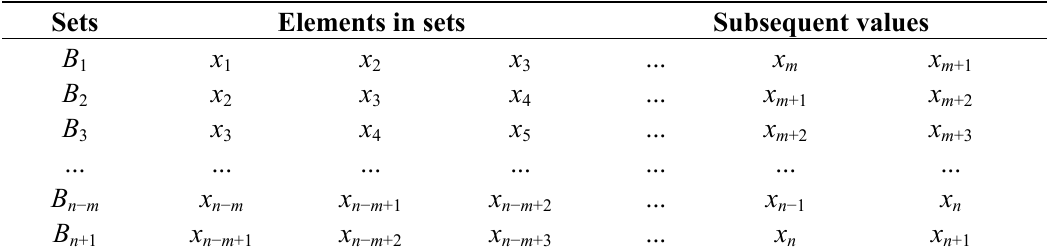
Table 1. The sets constituted from hydrological time series